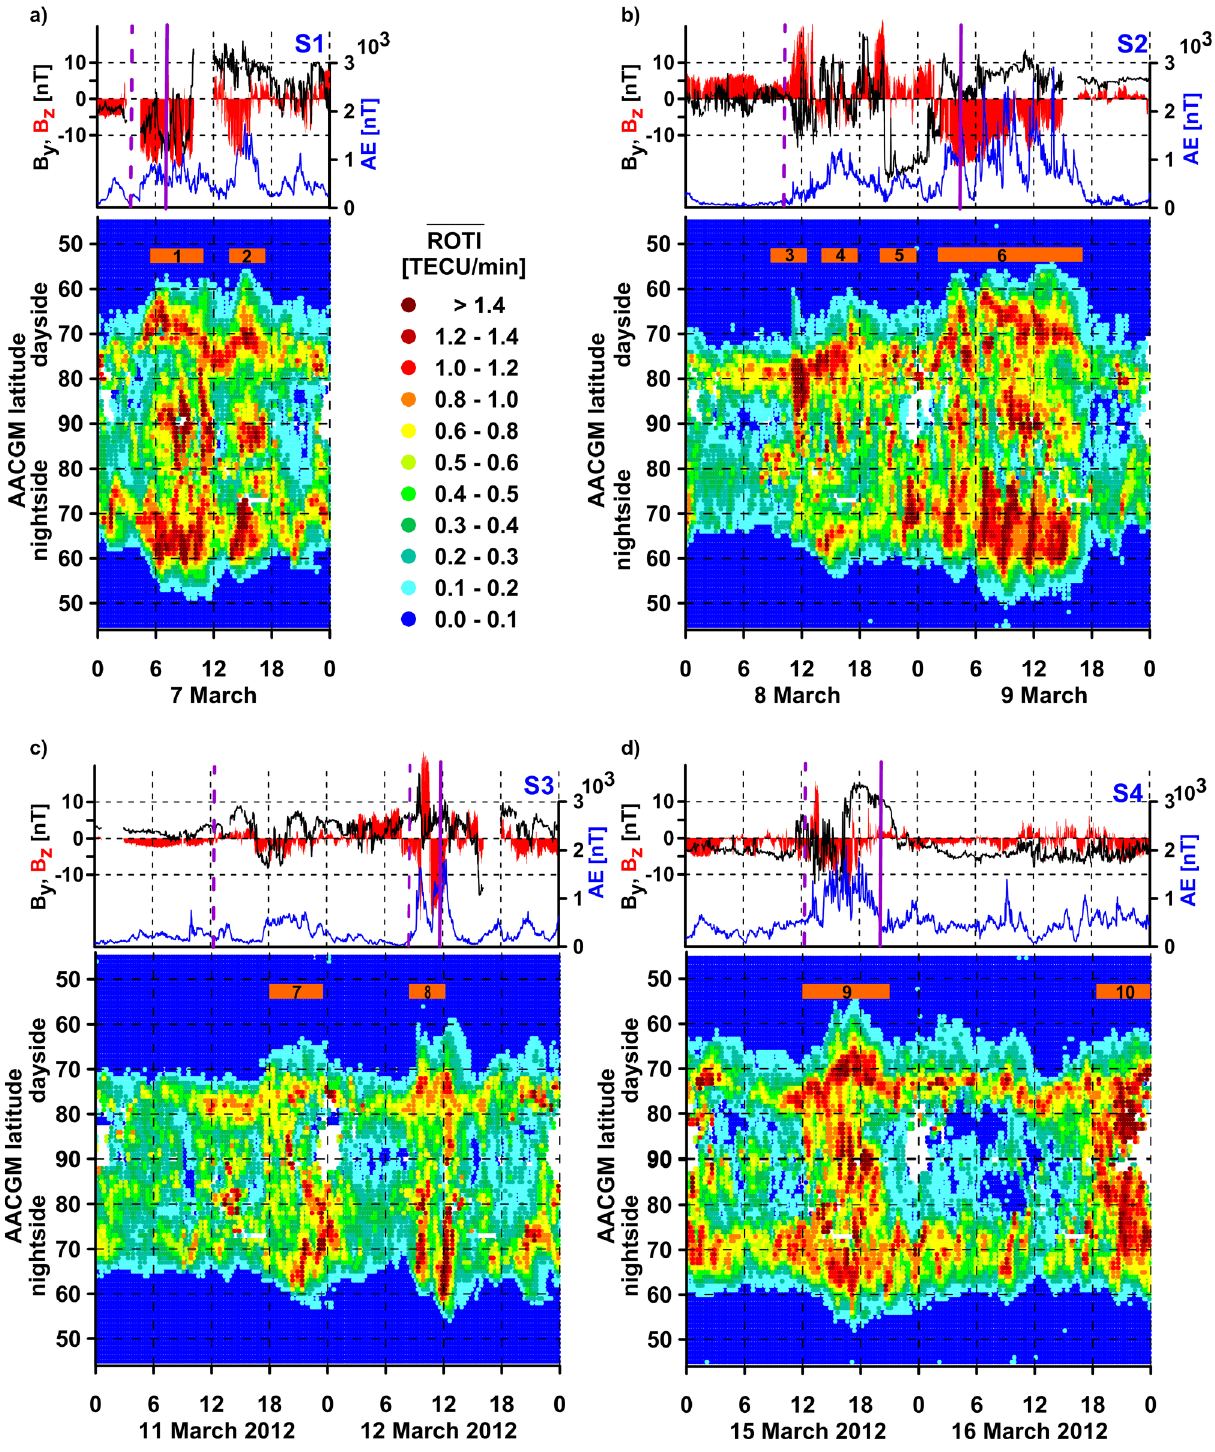
Fig. 13. The average ROTI values observed on both sides of ionosphere during events S1 – S4 (a – d), consecutive periods with high TEC fl uctuation are labelled with numbers. Top panels present variations of geomagnetic indices. IP shocks and minima of SYM-H index for S1 – S4 are marked with dashed and solid purple lines,